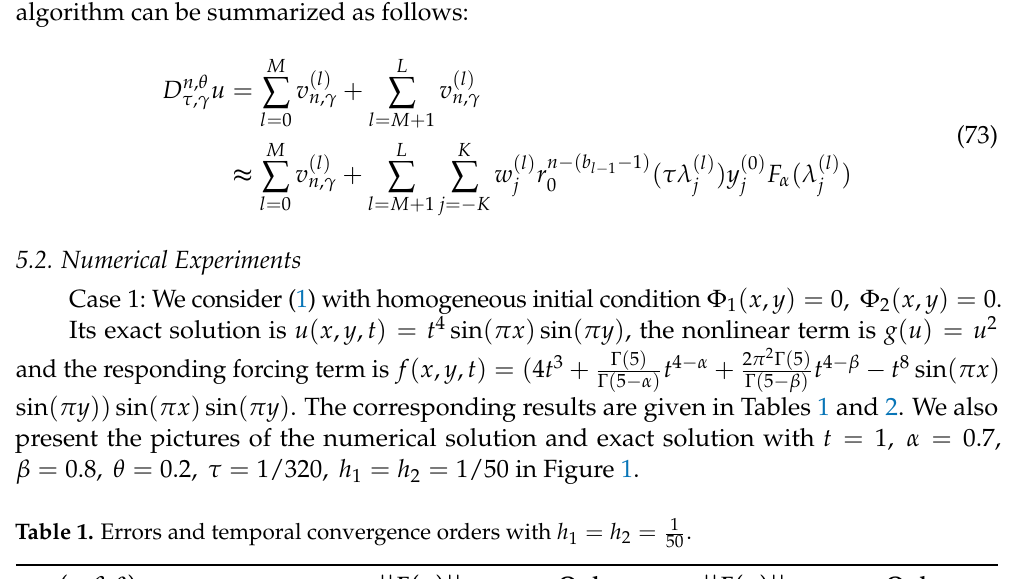
Table 1. Errors and temporal convergence orders with h 1 = h 2 = 1